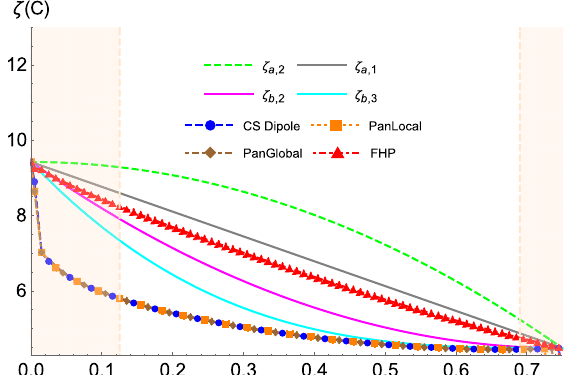
Fig. 3 Fixedordercalculationof ζ( C ) withindifferentrecoilschemes, compared to the analytic profiles given in the main text. The unshaded area indicates the typical C region where the fit of α s is performed. The CS Dipole, PanLocal and PanGlobal results